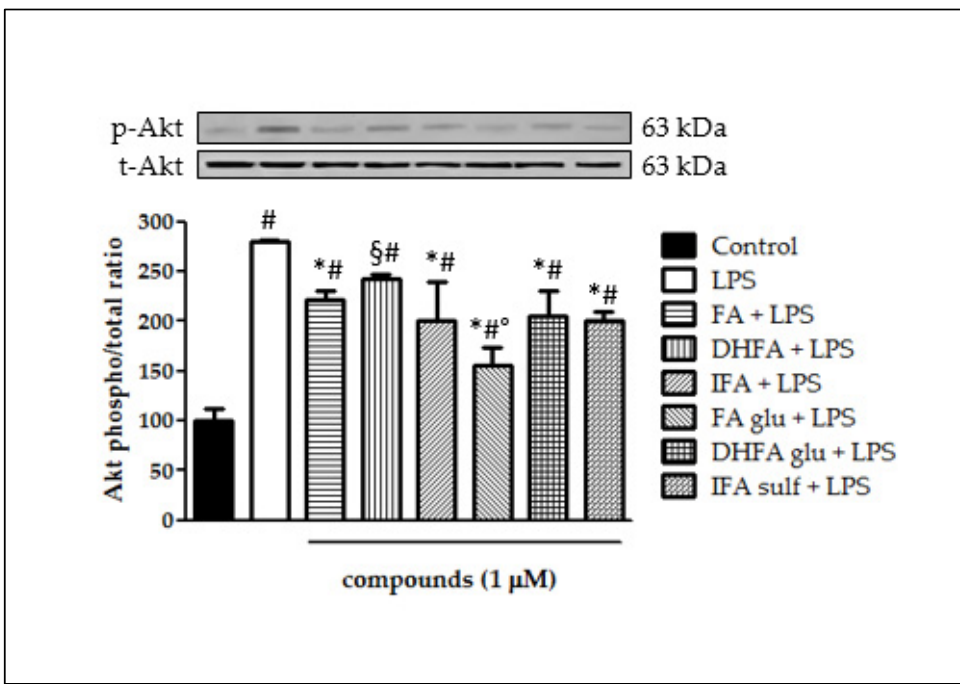
Figure 7. Activation of Akt reported as percentage of the control phospho Akt/total Akt ratio in Caco-2 cells treated with LPS (1 µ g/mL) for 2 h and pretreated for 30 min with FA, DHFA, IFA, FA glu, DHFA glu, and IFA sulf (1 µ M) preceding LPS co-exposure. Control and LPS groups were pretreated with an equivalent volume of methanol. Each column represents the mean ± SD of inde ‐ pendent experiments ( n = 6). Significant differences among groups are described using different superscript symbols; # = significant vs. control ( p < 0.001); * = significant vs. LPS ( p < 0.001); § = significant vs. LPS ( p < 0.05) and vs. FA glu + LPS ( p < 0.001); ° = significant vs. FA + LPS, IFA + LPS, DHFA glu + LPS and IFA sulf + LPS ( p < 0.01). Representative WB picture of the experiment is shown.